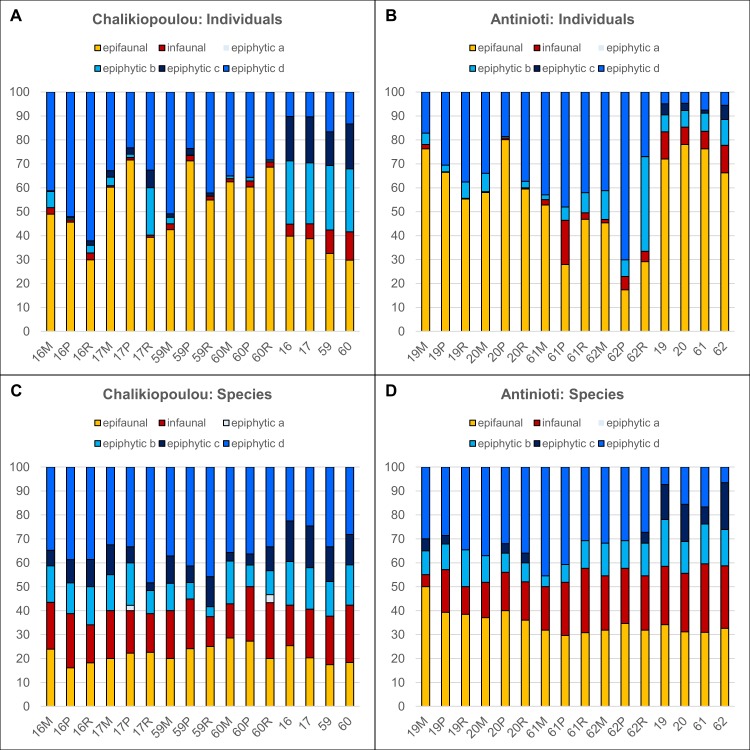
Distribution of relative abundances foraminifera belonging to six functional groups within in situ and experimental assemblages.See text for details on group assignments. (A) Individuals from Chalikiopoulou lagoon. (B) Individuals from Antinioti lagoon. (C) Species from Chalikiopoulou lagoon. (D) Species from Chalikiopoulou lagoon.